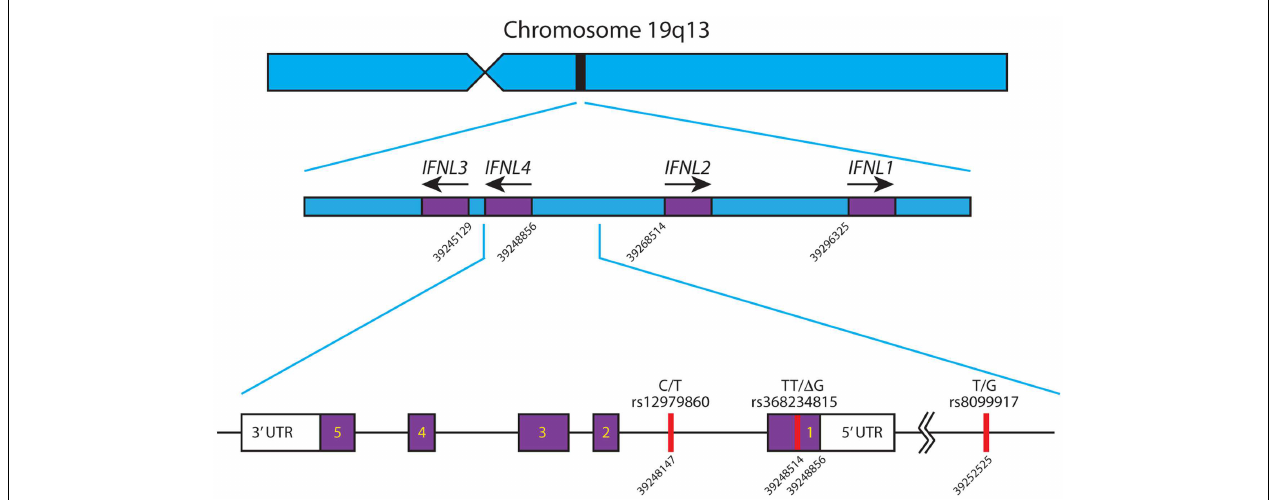
their corresponding nucleotide position. IFNL4 is located on the reverse strand of chromosome 19, has 5 exons and 3 (cid:48) /5 (cid:48) untranslated regions. All nucleotide positions are based on Ensembl genome assembly GRCh38 (December 2013), updated August 2014, database version 76 (45). Adapted from Ref.